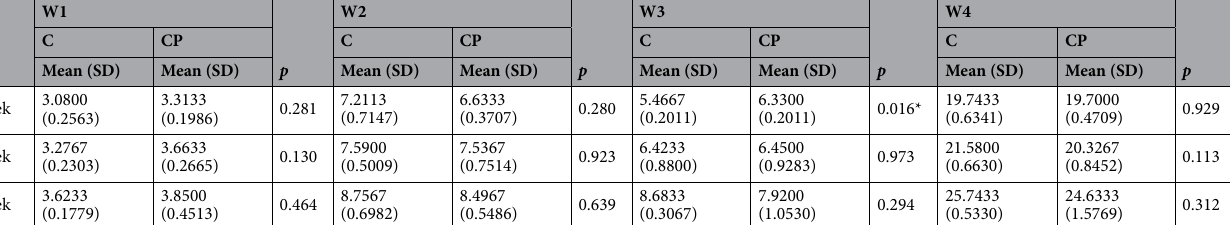
Table 4. Statistical values for width measurements of the maxilla using computed tomography three- dimensional reconstructions. Mean values, standard deviation (SD) and p values of each distance index are shown for each group ( C control group; CP cleft palate group) at each time point in development. * p < 0.05. Maxillary width: W1 (K–L), W2 (M–N), W3 (E–F), W4 (X–Y).